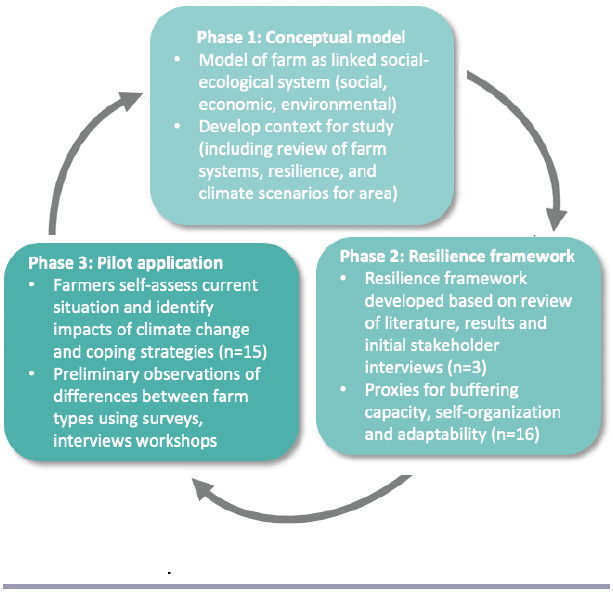
Fig. 2 . Developing and applying the resilience